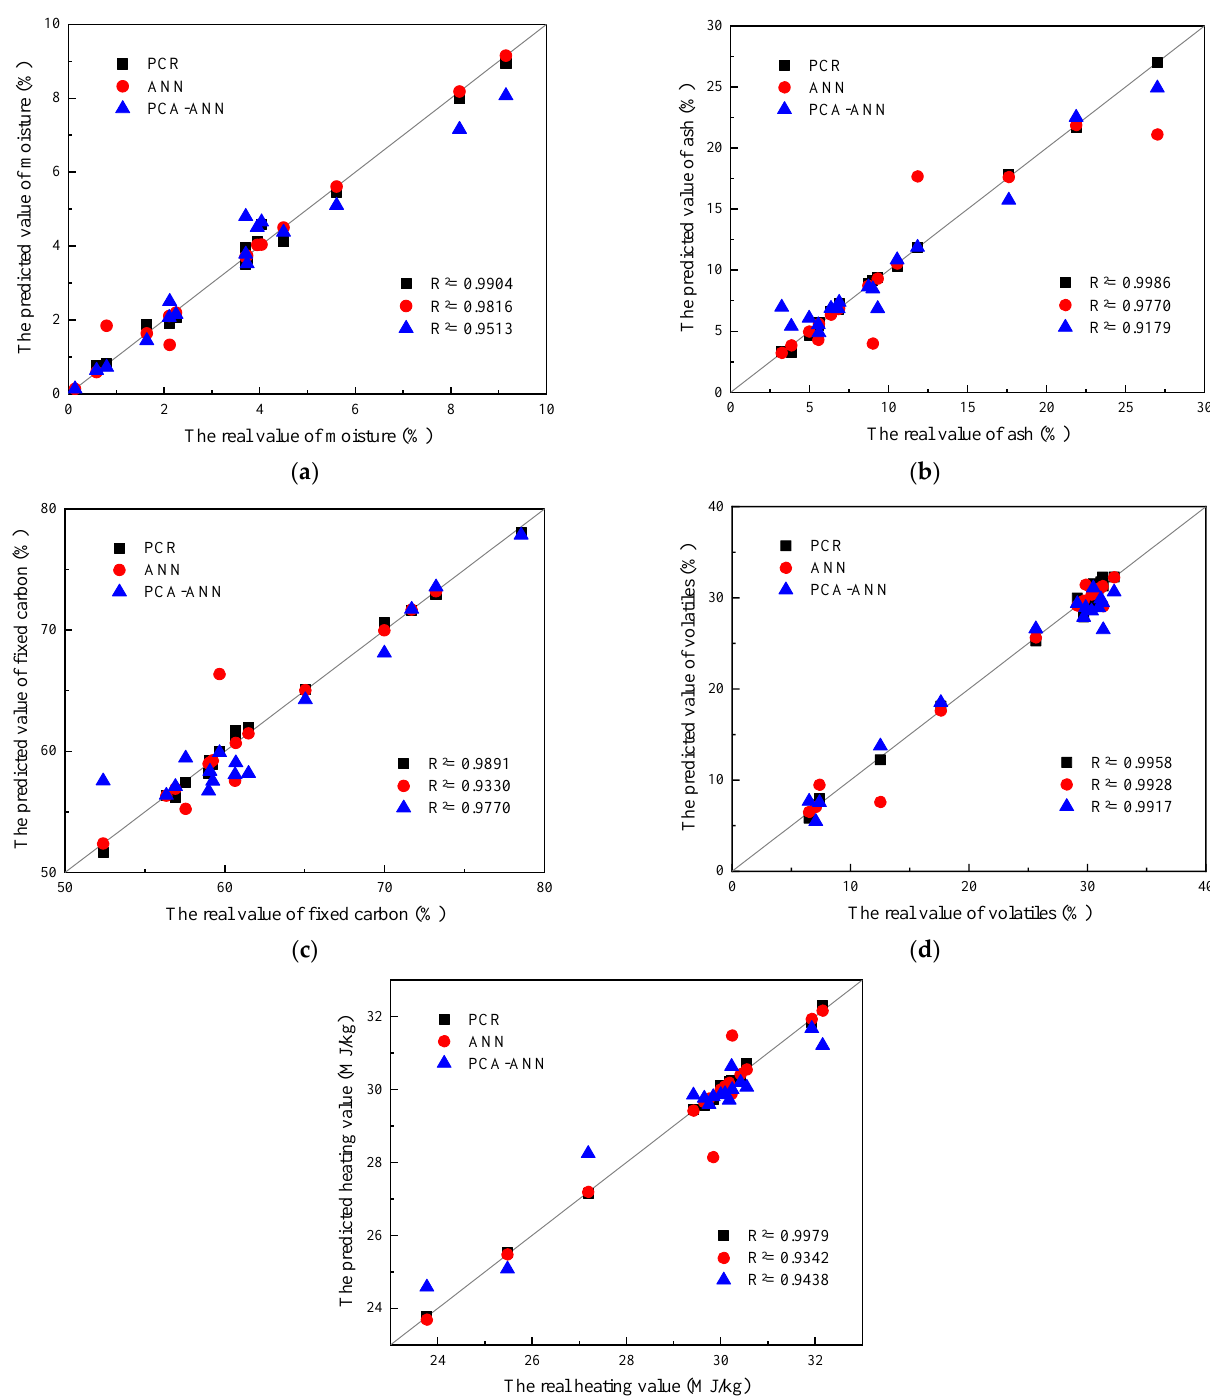
Figure 8. Comparison of predicted and real values of moisture ( a ), ash ( b ), fixed carbon ( c ), volatiles ( d ), and heating value ( e ) on an air-dries basis by three different chemometric methods.